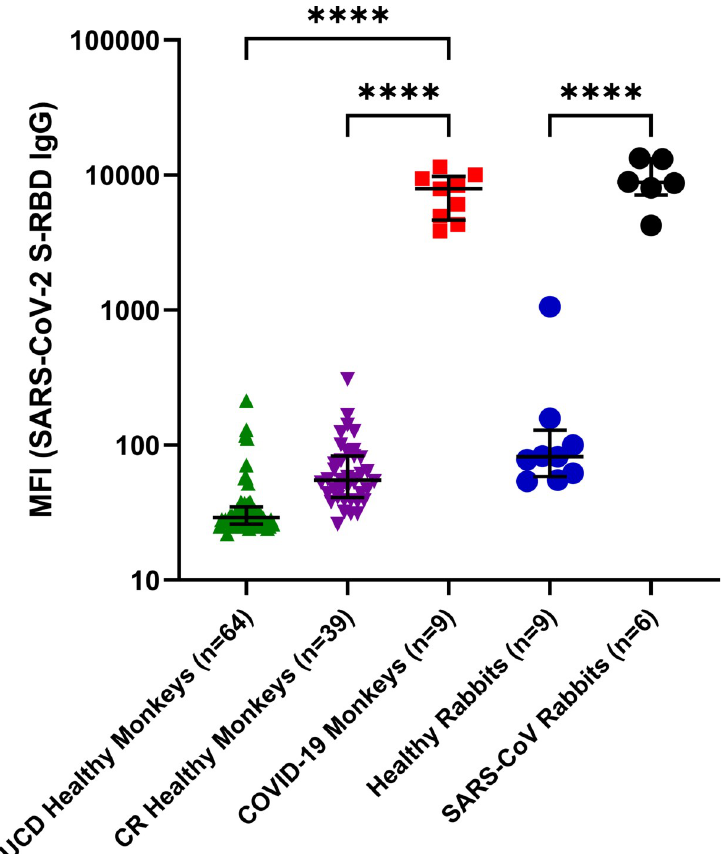
Fig 1. Detection of specific antibody responses (IgG) against SARS-CoV-2 S Protein RBD domain (S-RBD) in rhesus macaques and rabbits as detected by the multiplex assay. Multiplex assay was performed to detect IgG antibodies against SARS-CoV-2 S-RBD, SARS-CoV S & N, MERS-CoV S-RBD and S proteins of 4 common coronaviruses. IgG antibodies only to SARS-CoV-2 (S-RBD) antigen as determined in a multiplex microbead assay format are shown as MFI here. MFI values in log10 scale with Interquartile Range (IQR) are shown. Healthy monkeys from UCD (UC Davis) and CR (Charles River), and rabbits were included as negative control animals. Statistical significance was tested by one-way ANOVA and Tukey’s multiple comparison test (P value < 0 � 0001 is denoted by ���� ).